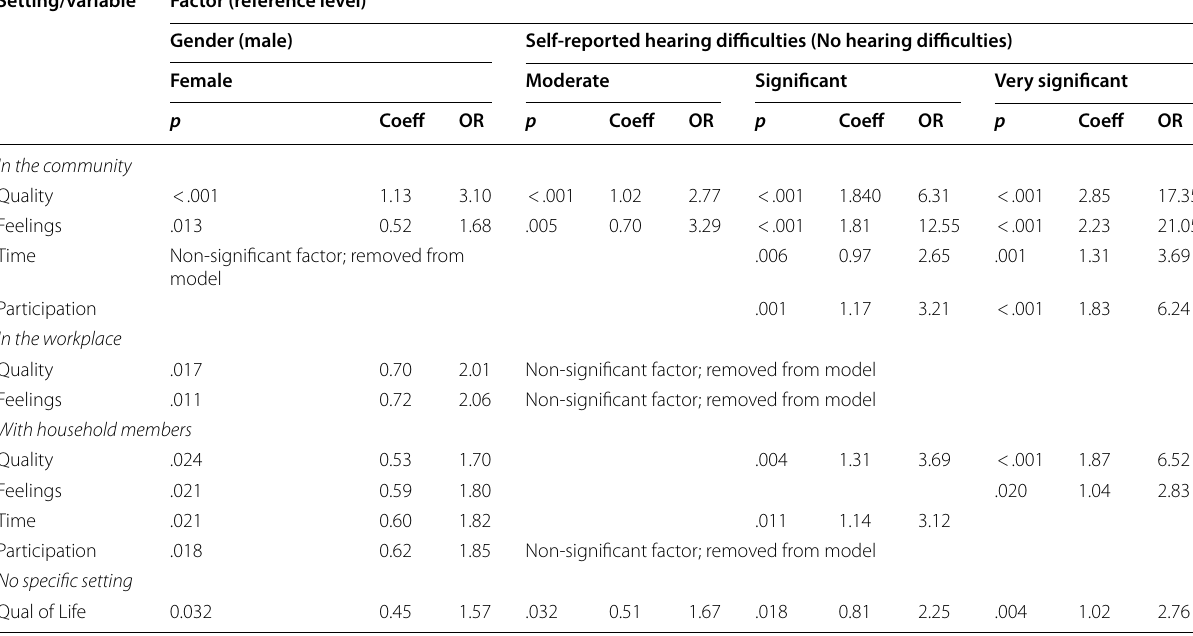
Table 2 Summarised outcomes of ordinal logistic regression analyses: factor levels with a significant effect on reported greater or lesser influence on the outcome variables for communication in the community, in the workplace or with household members